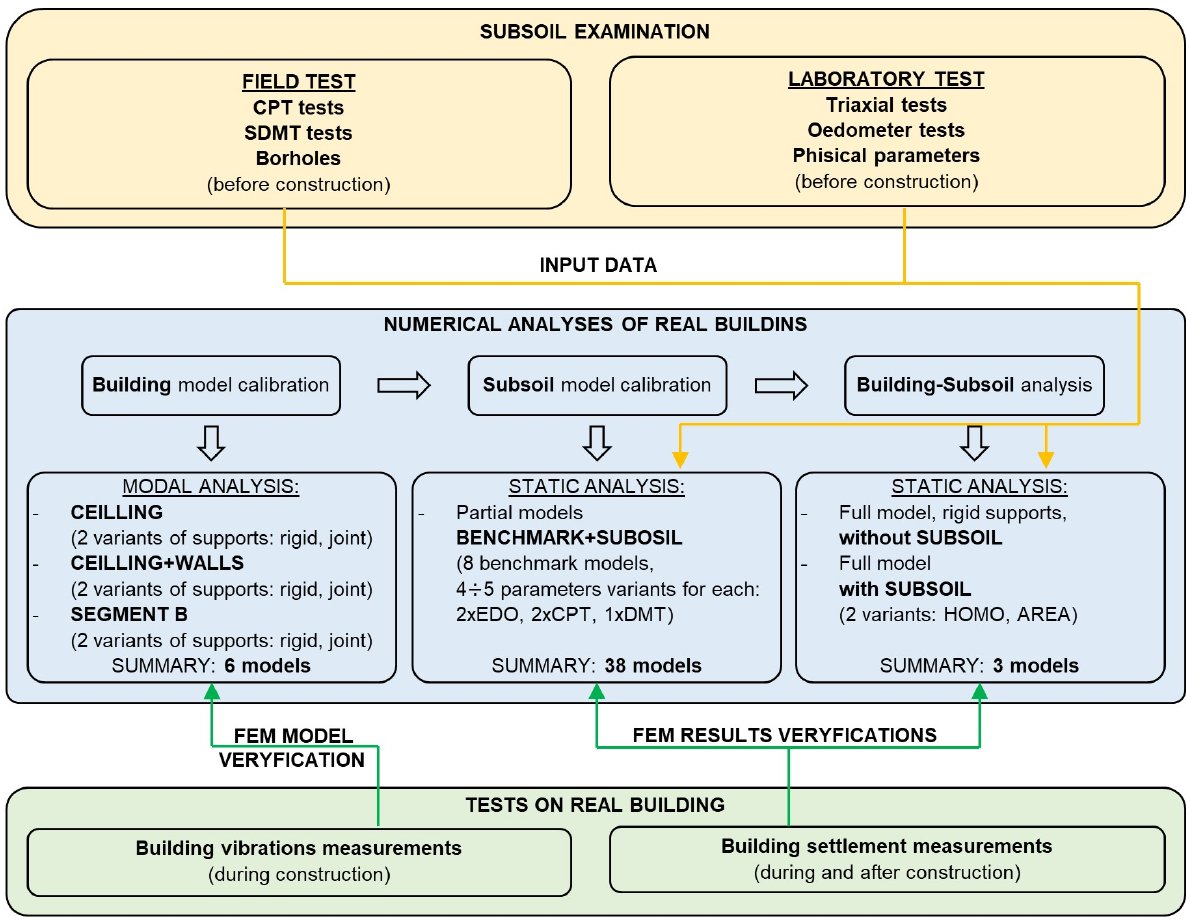
Figure 1. A scheme of the analysis